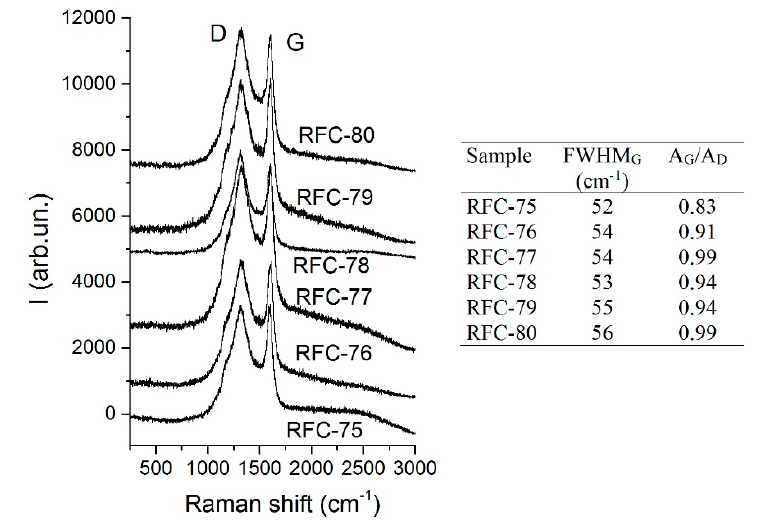
Figure 3. Raman spectra of the nanocomposites.